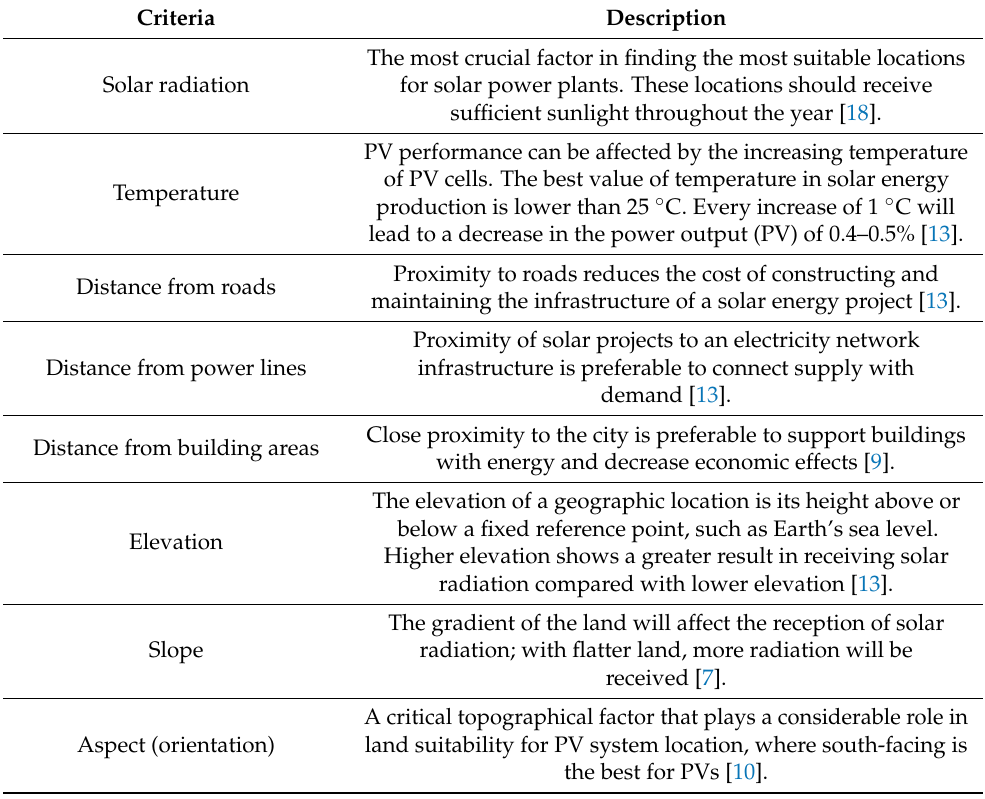
Table 3. Description of the evaluation